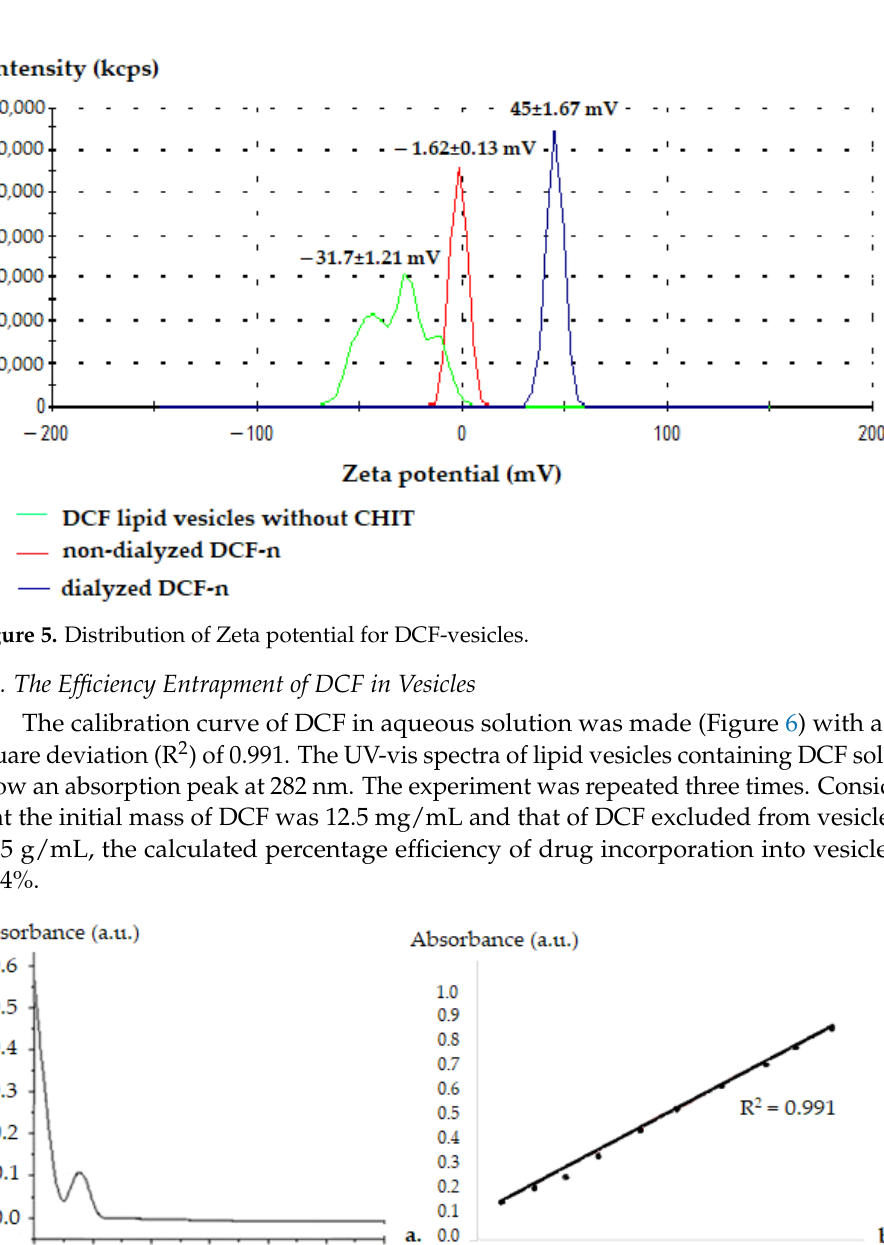
Figure 7. The absorption spectra of DCF and DCF-ves (legend: a.u. – absorption units, λ– wavelength). Detailing the aspects of the kinetic profile of the drug, it was found that, after 30 min, 53.4% DCF was released from the DCF solution, while only 8.2% was released from the DCF-ves. Drug release reached a percentage of 92.6% from DCF solution and 39.6% from DCF-ves after 90 min. The active substance was 100% released from the DCF solution after 120 min. Finally, the release of DCF from lipid vesicles appeared to be efficient, reaching a maximum of 93.6% after 6 h (Figure 8). The lower percentage of drug released